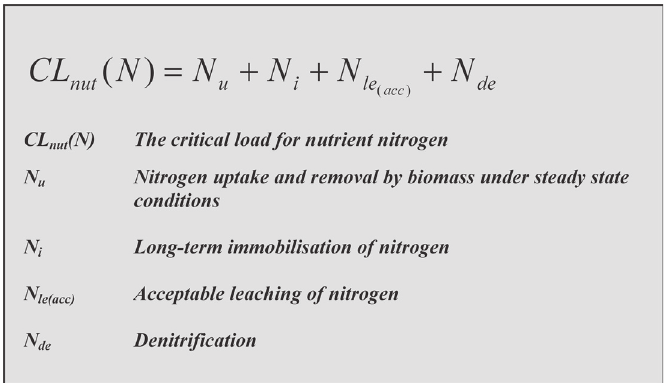
FIGURE 4 . Derivation of critical loads for eutrophication (nutrient nitrogen).